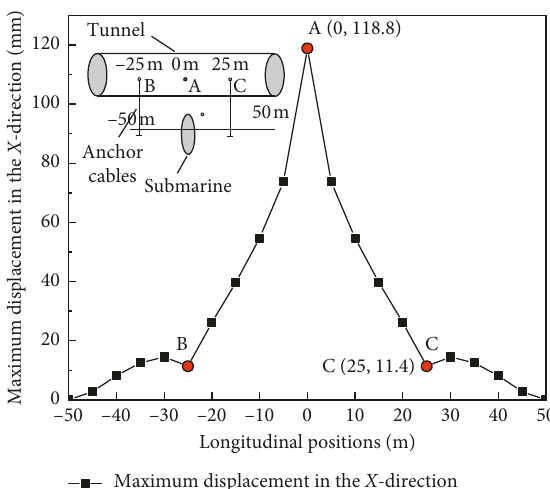
Figure 7: Maximum X -direction displacement at different longitudinal positions.